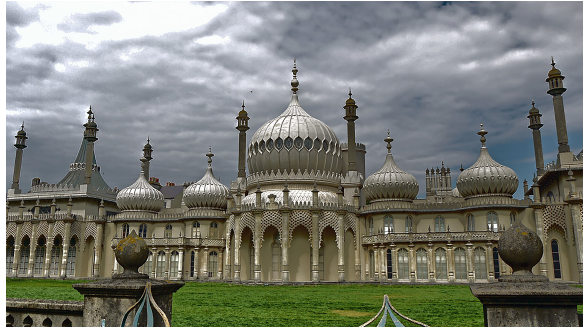
Figure 1: The Royal Pavilion [11].